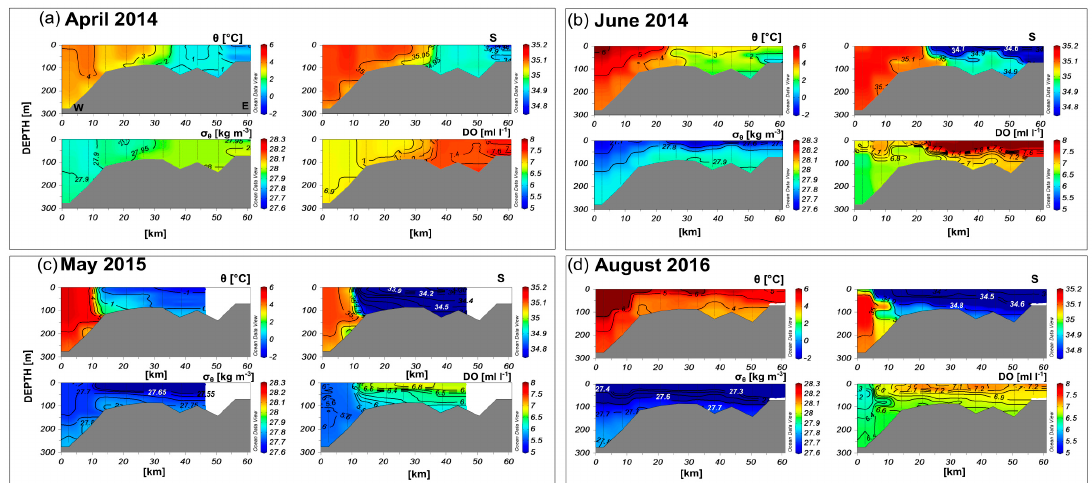
Figure 2. θ (°C), S, σ θ (kg m − 3 ), DO (mL L − 1 ), along the W–E section P (see Figure 1) in April 2014 ( a ),